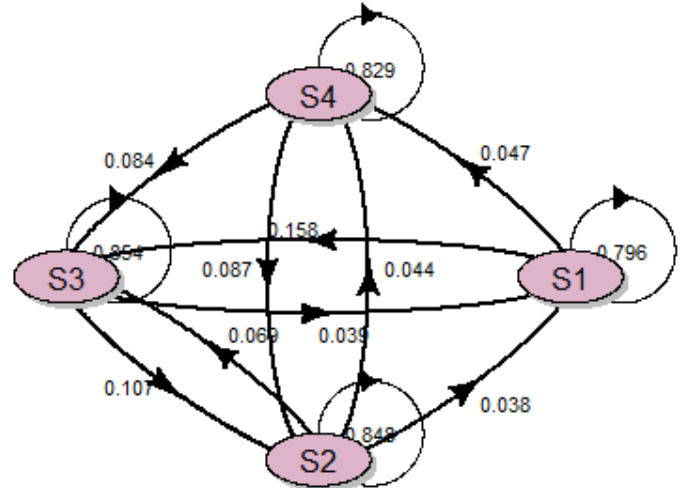
Figure 5. Transition matrix for hidden states.